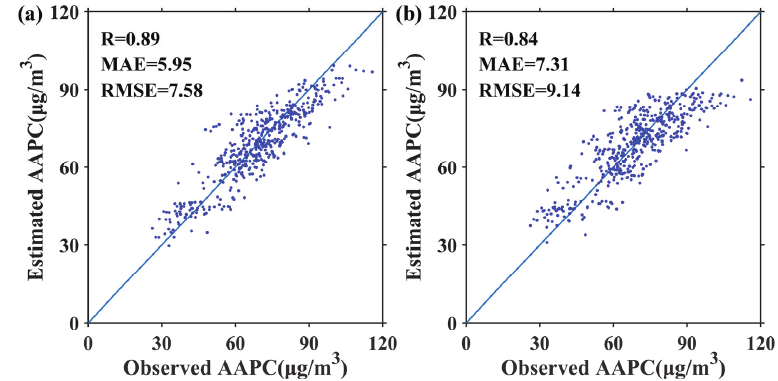
Figure 4. Scatterplots between estimated annual average PM 2.5 concentration (AAPC) and ground observation by using SHM ( a ) and UM ( b ) over the study area during 2015–2017.